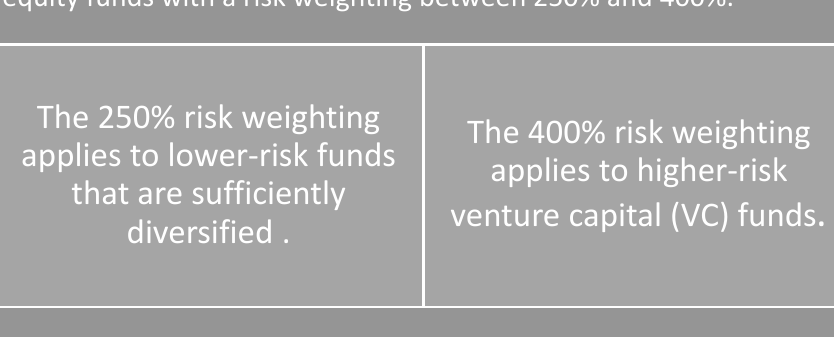
Figure 2. The BASEL III guidelines.